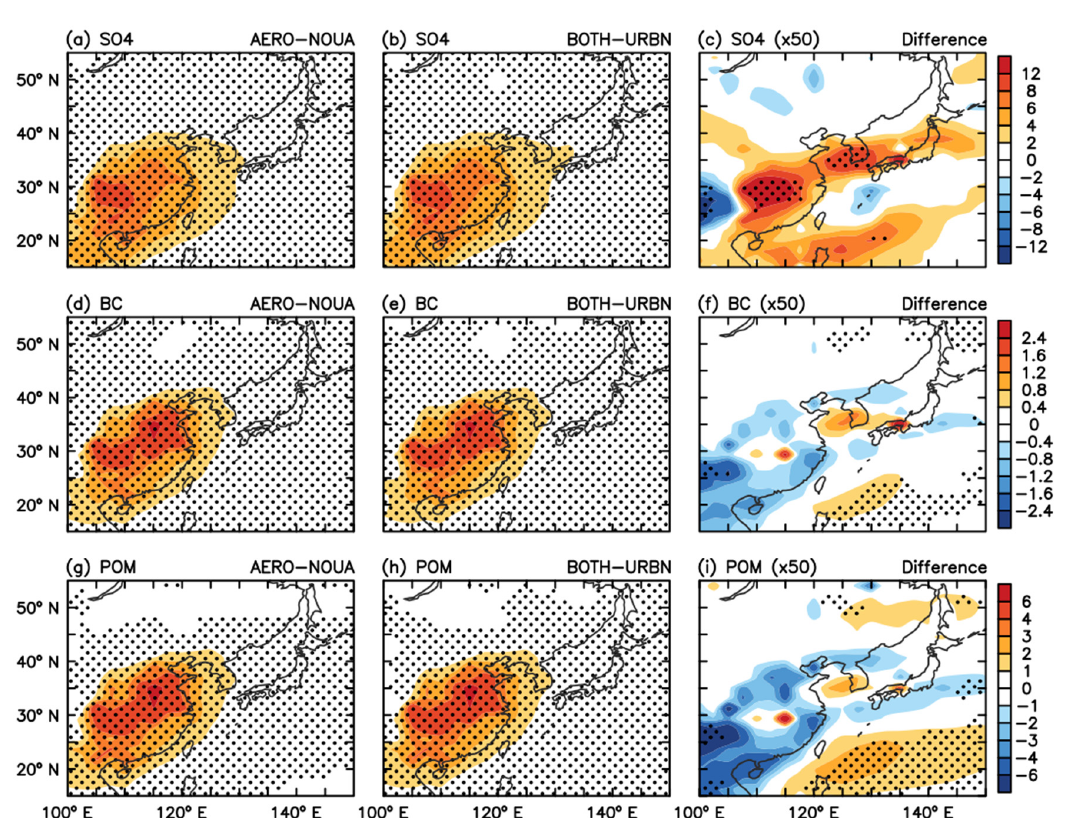
Figure 3. ( a – c ) NDJ-mean change in sulfate (SO 4 ) aerosol column burden (in mg/m 2 ) over East Asia from ( a ) AERO − NOUA; ( b ) BOTH − URBN; and ( c ) their difference (i.e., ( b ) minus ( a ): multiply by a factor of 50 in order to use the same color table). ( d – f ) Same as ( a – c ), respectively, but for black carbon (BC). ( g – i ) Same as ( a – c ), respectively, but for primary organic matters (POMs). The stippling indicates the change or difference is statistically significant at the 90% confidence level based on the Monte-Carlo (MC)